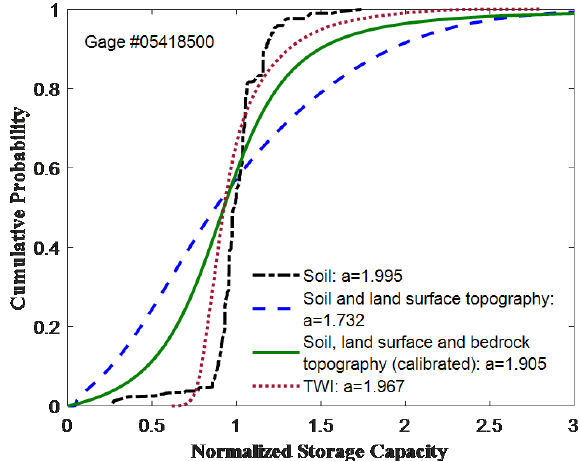
Figure 7. The effects of soil, land surface topography, bedrock to- pography, and topographic wetness index (TWI) on the shape pa- rameter of the spatial distribution of soil water storage